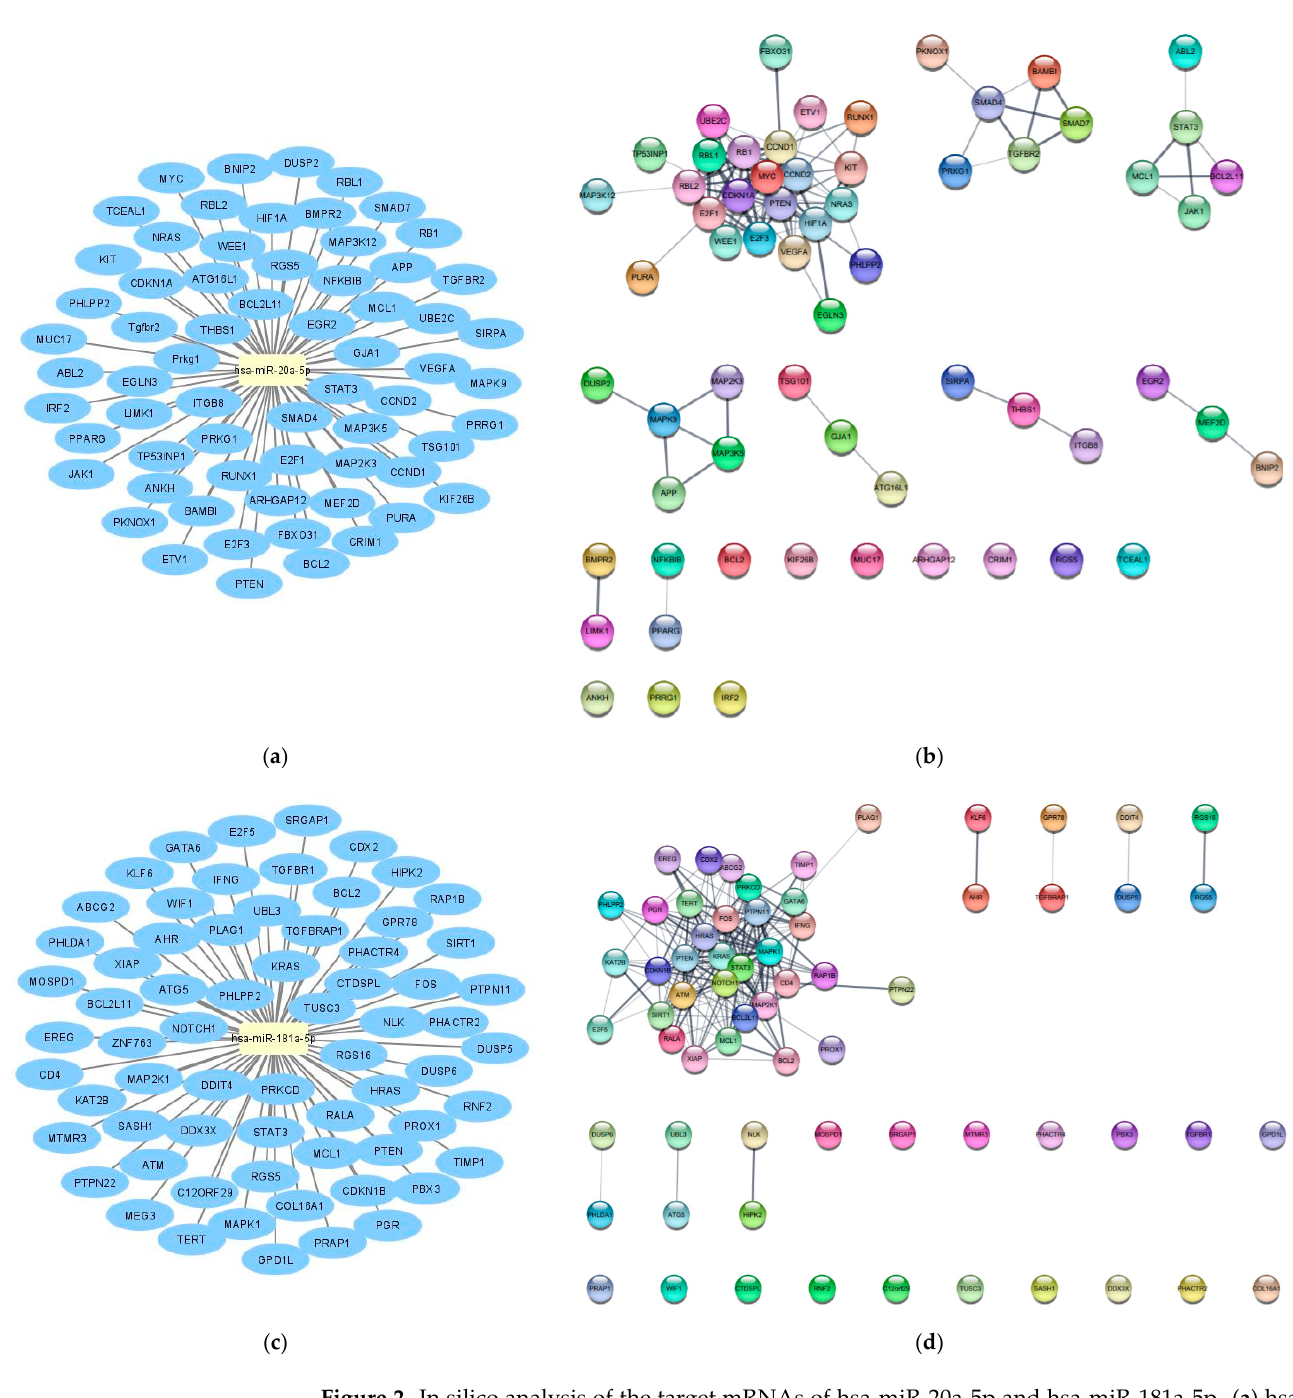
Figure 2. In silico analysis of the target mRNAs of hsa-miR-20a-5p and hsa-miR-181a-5p. ( a ) hsa- miR-20a-5p target mRNAs according to miRTarBase database analysis; ( b ) target mRNAs of hsa- miR-20a-5p organized by string interactions clusters; ( c ) hsa-miR-181a-5p target mRNAs according to miRTarBase database analysis; ( d ) target mRNAs of hsa-miR-181a-5p organized by string inter- actions clusters.